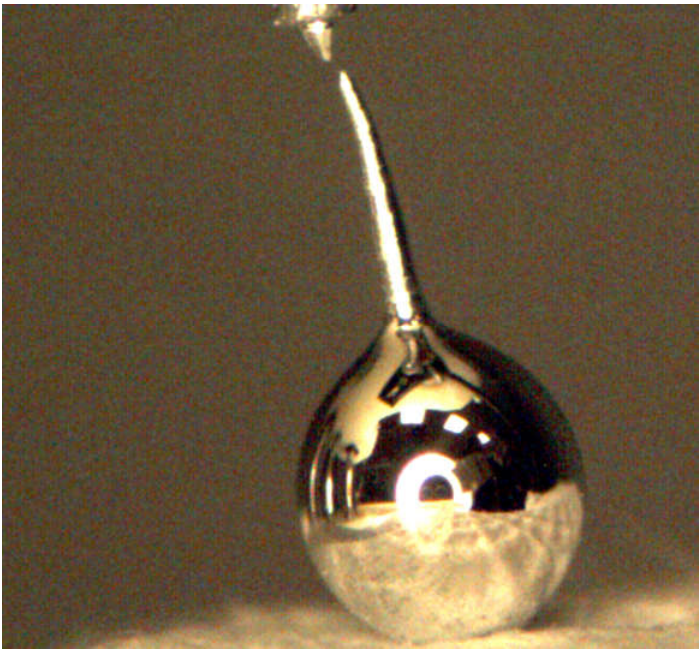
Figure 3. Extended outgrowth formed by the needle channel at a slow retraction